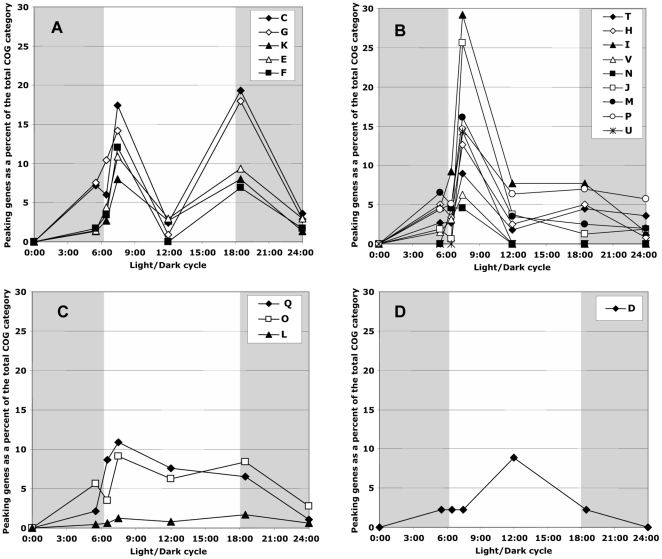
Different patterns in peaking genes classified with regard to their COG functional category (C, D, E, F. G, H, I, J., K, L, M, N, O, P, Q, T, U, V).
A. Genes peaking both at 7:30 and 18:30. B. Genes only peaking at 7:30. C. Genes showing maximum expression throughout the light period. D. Gene only peaking at12:00. For each COG (cluster of orthologous genes) category, we estimated the percentage of genes (belonging to this category) displaying a zenith (Peak up) or a nadir of their transcript abundance (Peak down) during the light/dark cycle. The gray shaded part of the figure represents the dark period of the light/dark cycle.